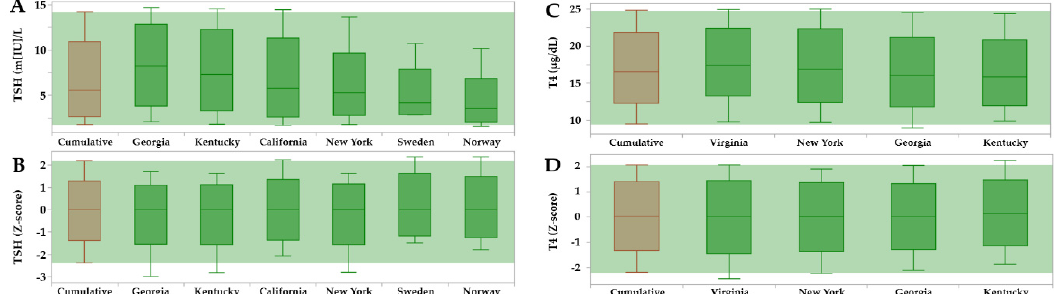
Figure 7. Reference Range Comparison of TSH and T4 reference ranges in dried blood spots by contributing sites. Legend: The horizontal green band overlays the cumulative peripheral percentiles (brown) on top of the individual sites (dark green). Locations are not aligned vertically because they were sorted left to right in descending order of the median separately in each panel. (Panel A ): unadjusted TSH ranges; (Panel B ): TSH ranges after adjustment for age (hours), birth weight (grams) and location, expressed as Z-scores; (Panel C ): unadjusted T4 ranges; (Panel D ): T4 ranges after adjustment for age (hours), birth weight (grams), and location, expressed as Z-scores.